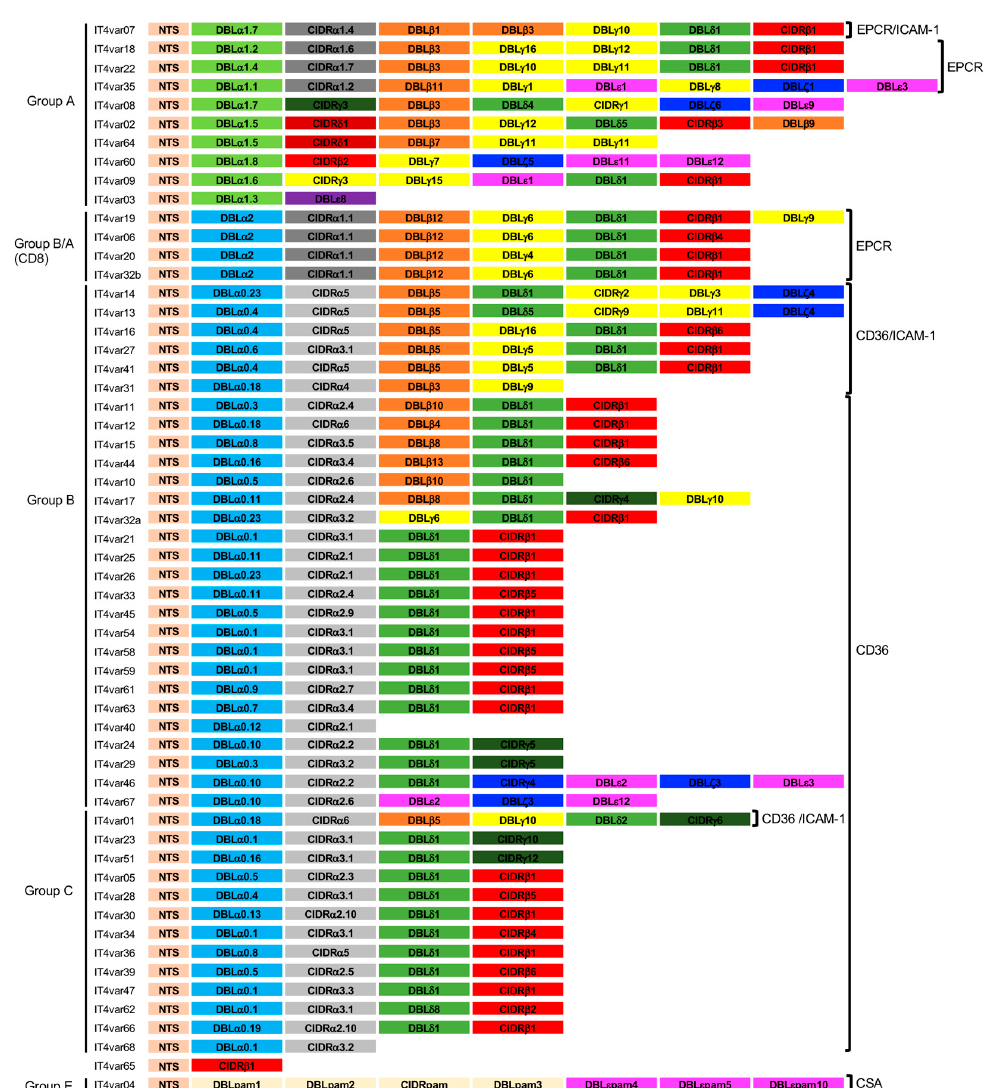
Figure 1. Pf EMP1 repertoire of the P. falciparum isolate IT4, adapted from [17]. ECR binding phe- notype [36]. Color code: light brown: N-terminal segment (NTS); bright green: Duffy binding-like (DBL) α 1; light blue: DBL α 2, DBL α 0; dark grey: Cys rich inter-domain regions (CIDR) α 1; light grey: CIDR α 2–6; dark green: CIDR γ ; orange: DBL β ; yellow: DBL γ ; green: DBL δ ; pink: DBL ε ; blue: DBL ζ ; purple: DBL ε ; IT4var04: light yellow: DBL/CIDRpam: pink: DBL ε pam.